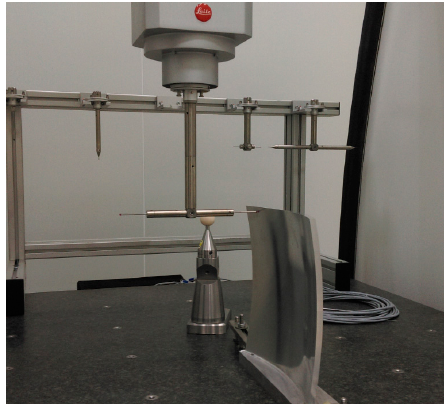
Figure 6. Measurement of form accuracy. Micromachines 2017 , 8 , 332